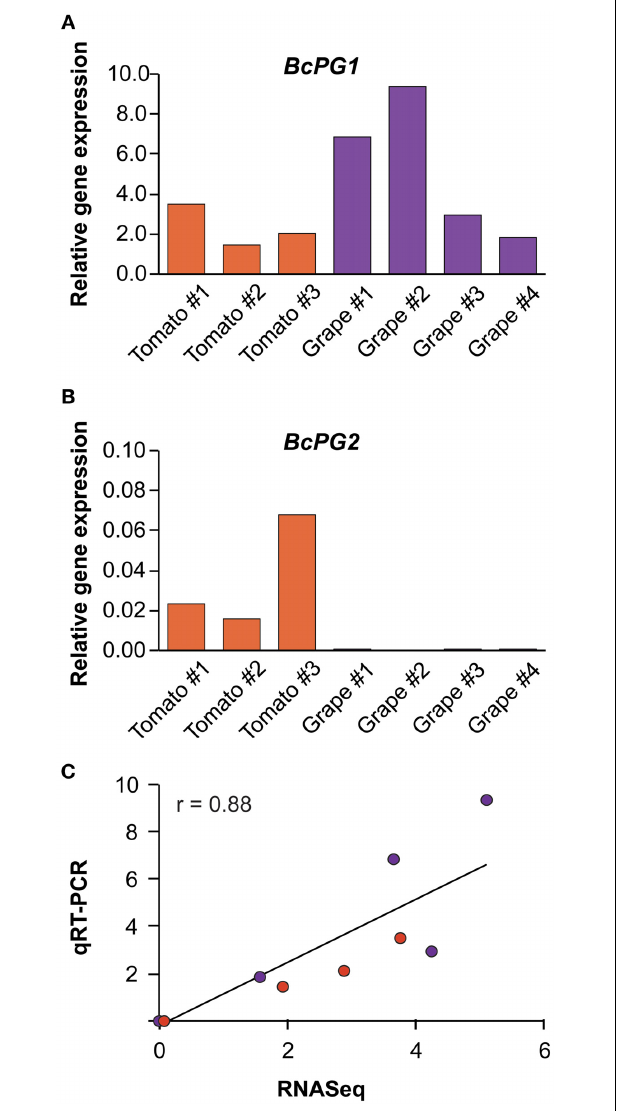
FIGURE 5 | qRT-PCR validation of the RNAseq expression results for BcPG1 and BcPG2 genes in ripe tomato fruit and grape berries. Relative expression levels of BcPG1 (A) and BcPG2 (B) measured in the biological replications of Botrytis -infected tomato fruit and botrytized-grape berries. (C) The scatterplot depicts the correlation between the qRT-PCR relative expression of BcPG1 and BcPG2 genes and their corresponding raw reads normalized against the same reference gene ( BcRPL5 ) used in the qRT-PCR analyses. The data points indicate that the BcPG2 expression in grape berries were close to zero (average of 4.49e − 5) and in tomato fruit the expression was 3.57e − 2 on average; thus they overlapped in the graph. The Pearson correlation coefficient (r) is presented ( P -value < 0.001). A linear trend is shown.